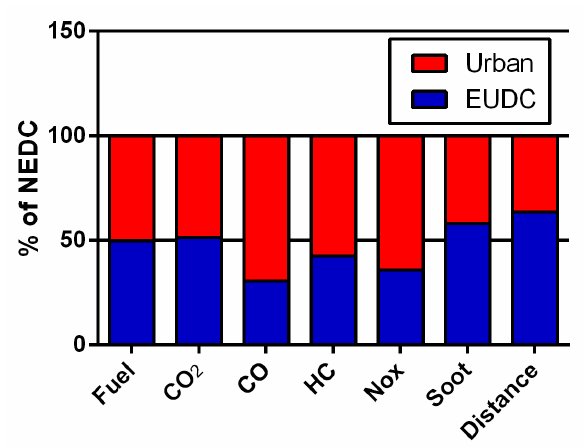
Figure 14. Repartition of emissions during NEDC in the original engine tested.